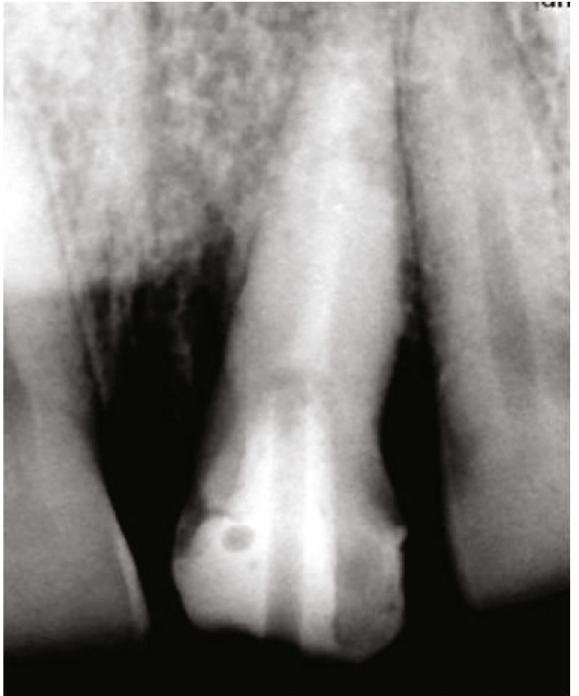
Figure 4: After postcementation.